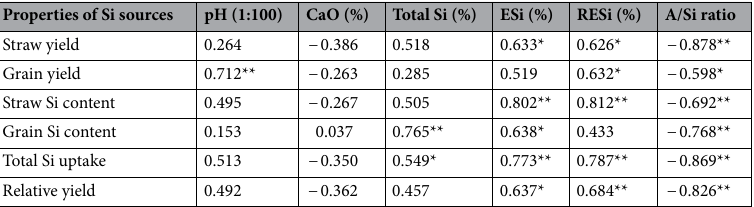
Table 4. Correlation between different properties of slags, yield and Si content of wetland rice [*significant at p < 0.05, **significant at p < 0.01 (each data represents an average of three replication)].